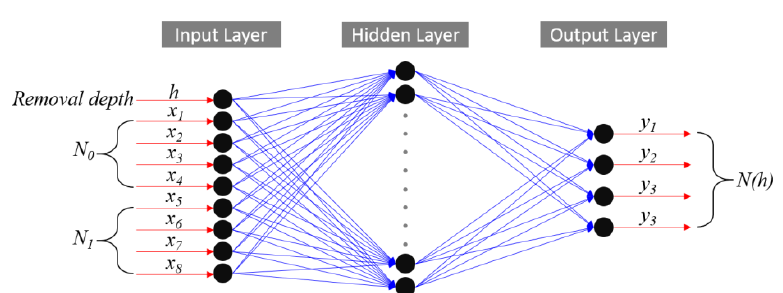
Figure 8. BP neural network structure diagram.